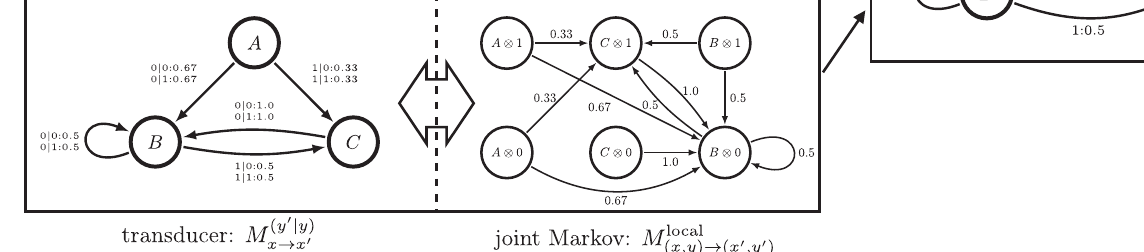
k T ln 2 extra heat per 3 B